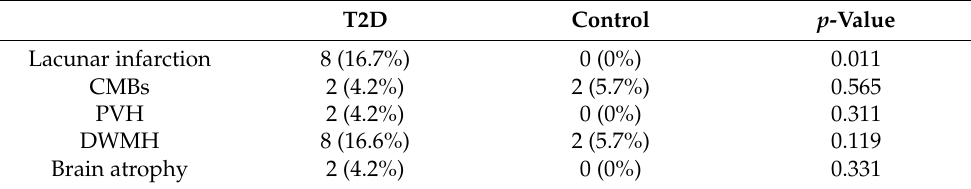
Table 2. Prevalence of SVD.